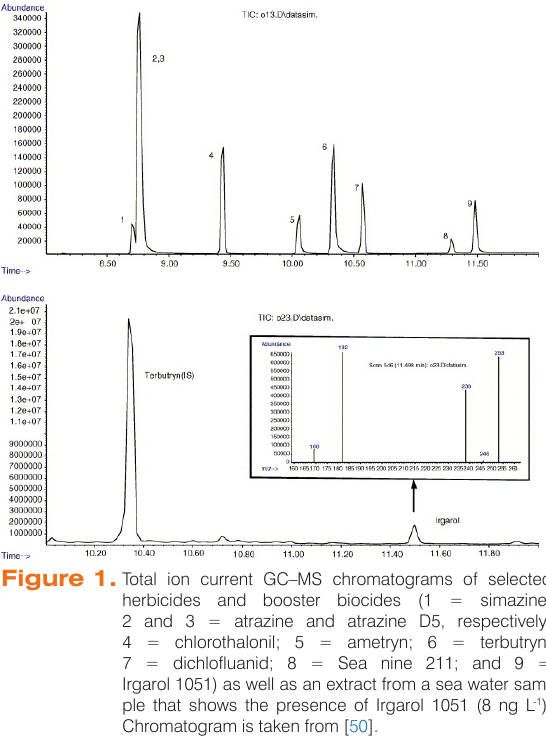
Figure 1. Total ion current GC–MS chromatograms of selected herbicides and booster biocides (1 = simazine; 2 and 3 = atrazine and atrazine D5, respectively; 4 = chlorothalonil; 5 = ametryn; 6 = terbutryn; 7 = dichlofluanid; 8 = Sea nine 211; and 9 = Irgarol 1051) as well as an extract from a sea water